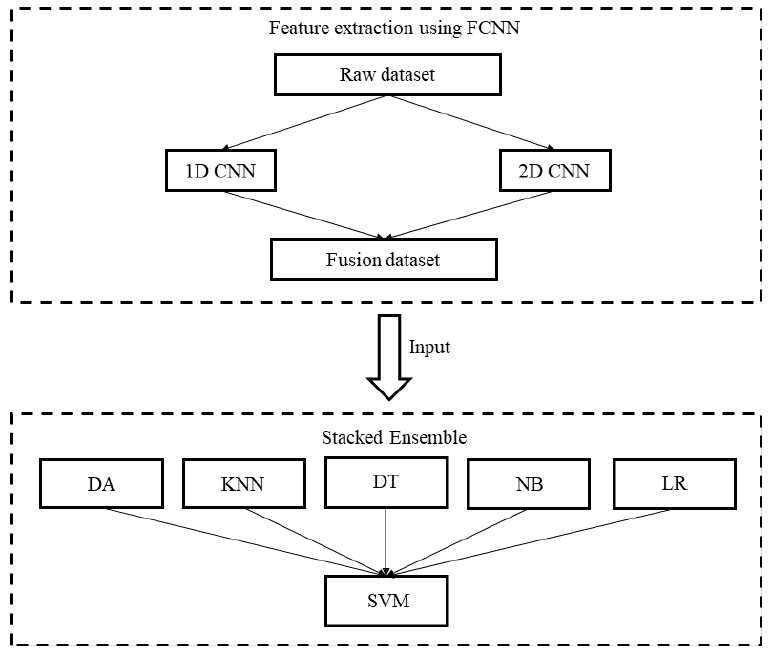
Figure 1. The FCNN-SE structure.